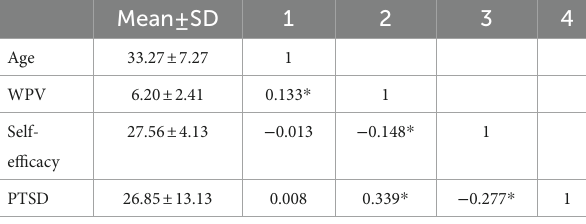
TABLE 2 Correlations among age, WPV, self-efficacy, and